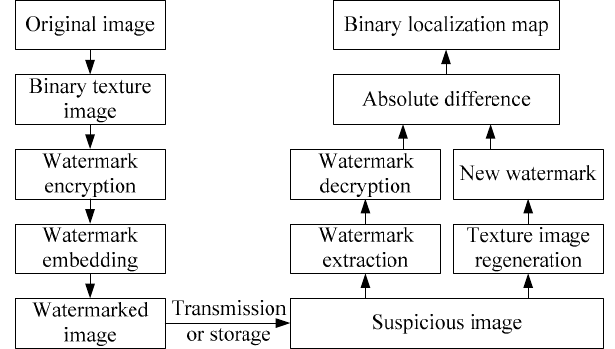
Figure 4. Block diagram of the presented fragile watermarking algorithm.